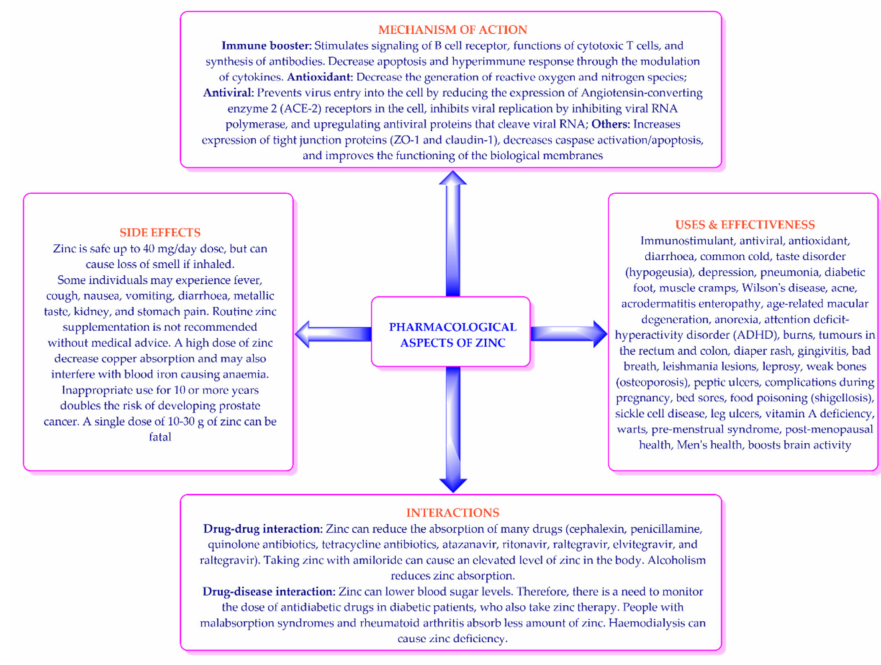
Figure 1. Mechanisms of action, uses, side effects, and interactions of